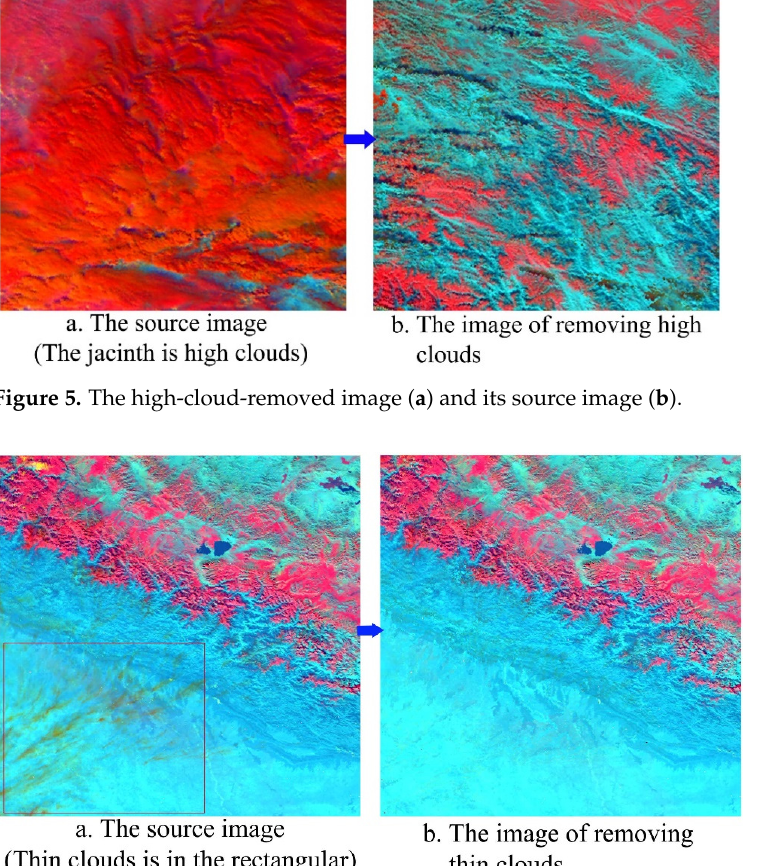
Figure 6. The thin-cloud-removed image ( a ) and its source image ( b ).